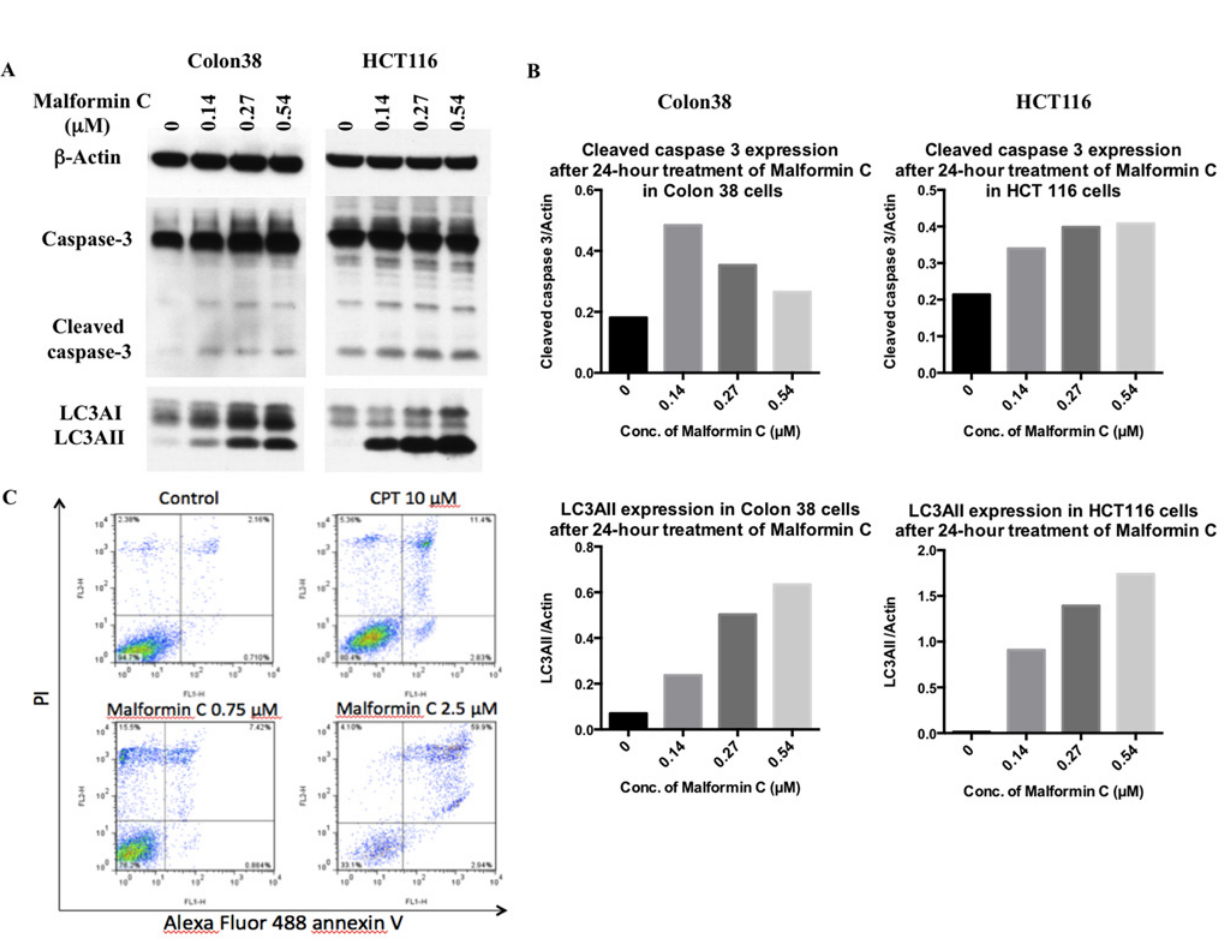
Fig 4. Expression of CASPASE 3 and LC3 and apoptosis assay in cells treated with Malformin C. (A, B) The expression of cleaved CASPASE 3, total CASPASE 3, LC3AI and LC3AII in Colon 38 and HCT 116 cells treated with different concentrations of Malformin C (0 μ M, 0.14 μ M, 0.27 μ M, 0.54 μ M for 24 hours was tested by Western blot, with β -Actin expression as an internal control. During autophagy process, LC3AI will be converted into LC3AII to be functional, so we analyzed LC3AII expression for autophagy process. (C) Malformin C led to late apoptosis and necrosis after 24-hour treatment examined by apoptosis assay. Untreated or Malformin C-treated Colon 38 cells (2×10 6 ) were stained with Alexa Fluor 488 annexin V and PI and processed by flow cytometer. The percentage of early apoptotic population (lower right panel), late apoptotic population (upper right panel) and necrotic population (upper left panels) is shown in the graph. CPT, a known apoptosis-inducing agent, was used as a control. Three independent experiments were performed with duplicates for each condition, and one typical result is shown here.